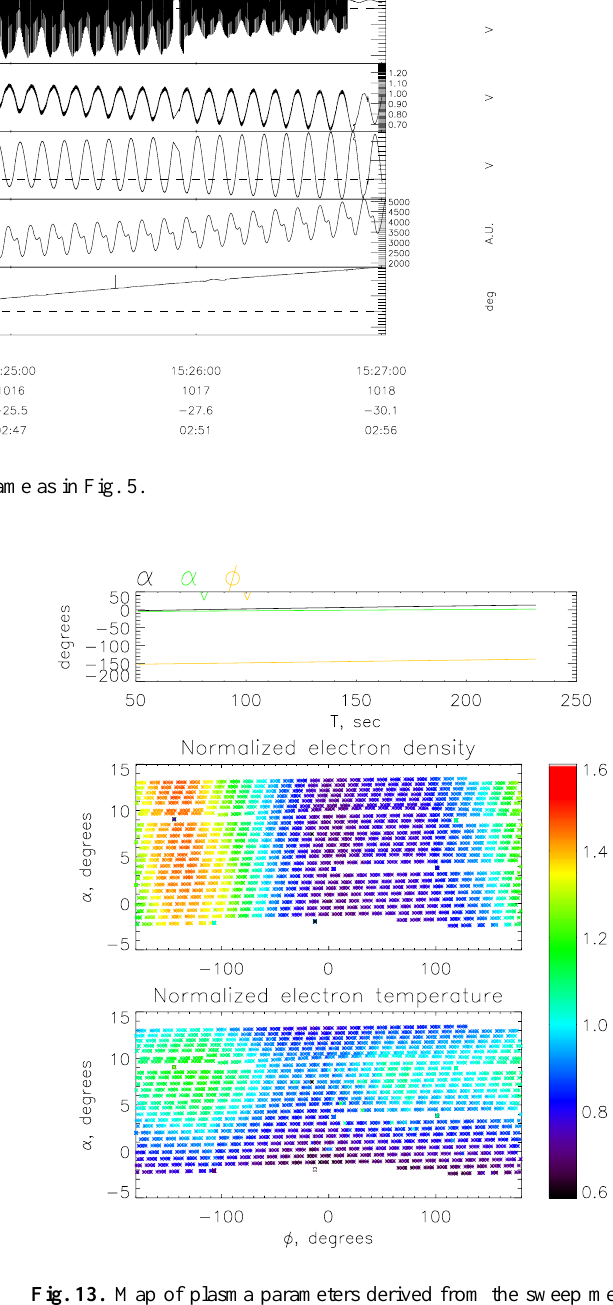
Fig. 13. Map of plasma parameters derived from the sweep mea- surements for Case 2 in (φ,α) coordinates. The format is the same as in Fig.